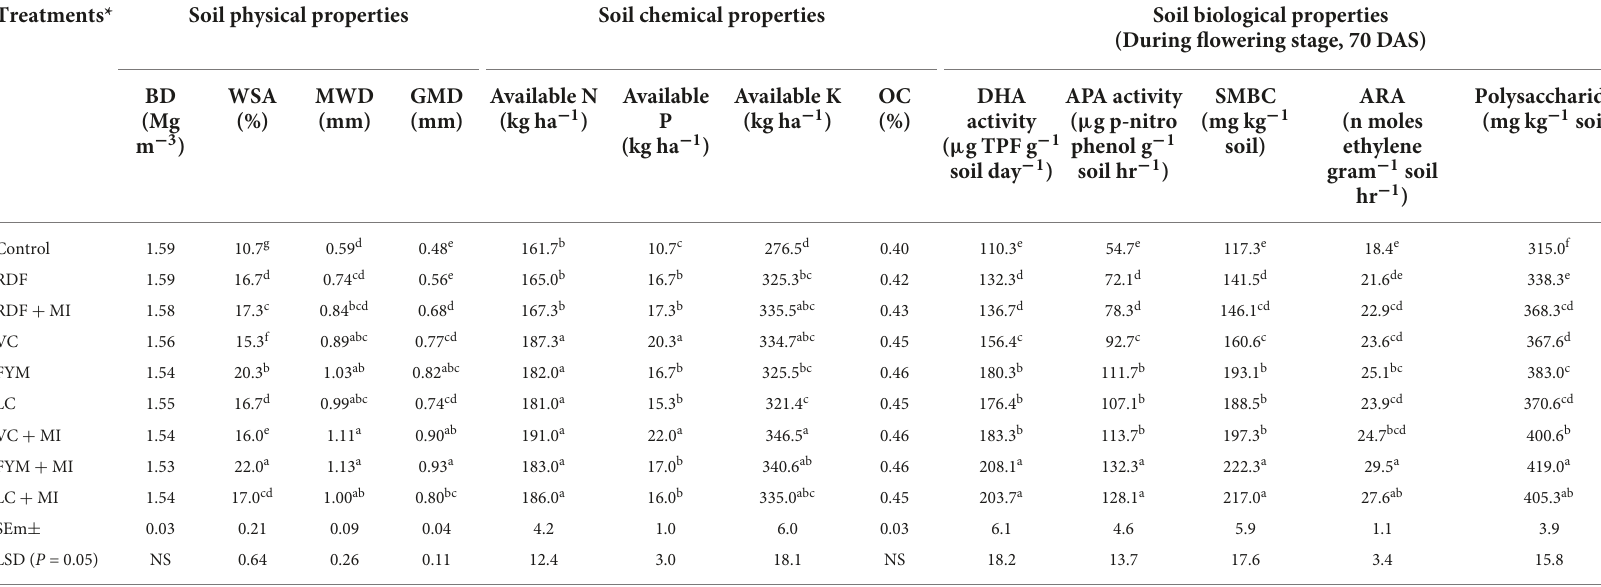
TABLE 6 Influence of microbial inoculants-mediated nutrient management on soil physical, chemical, and biological properties (at the end of the 2-year experiment).